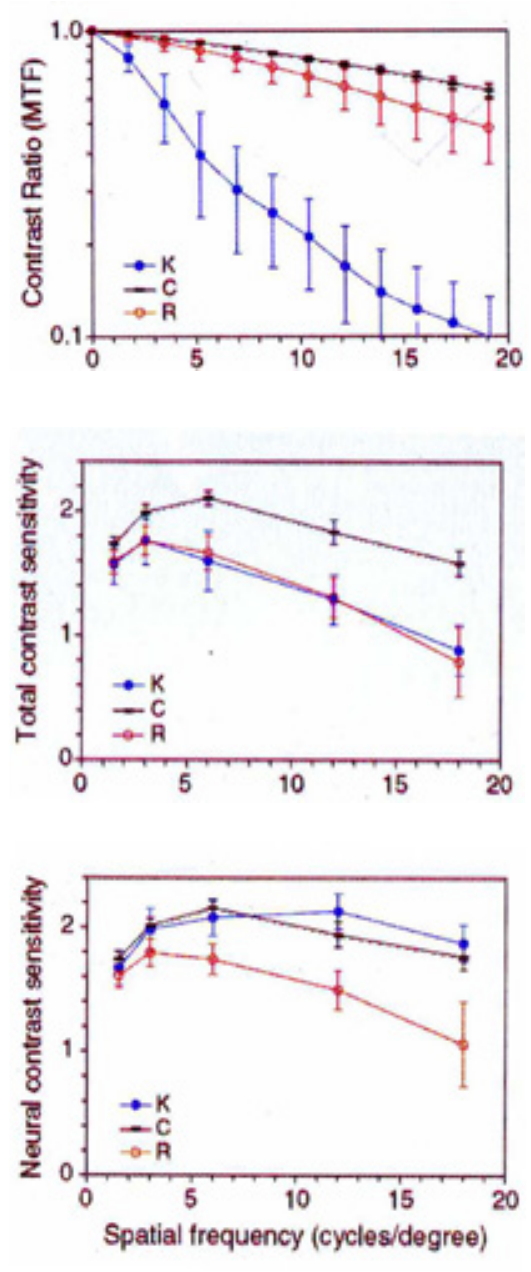
Figure 6 . Mean and confidence intervals of Neural Contrast Sensitivity, Modulation Transfer Function and Total Contrast Sensitivity compared in three groups, controls (C) in black, diabetic retinopathy(R) in red, and keratoconus (K) in blue, in a study by Micheal et al 20 .